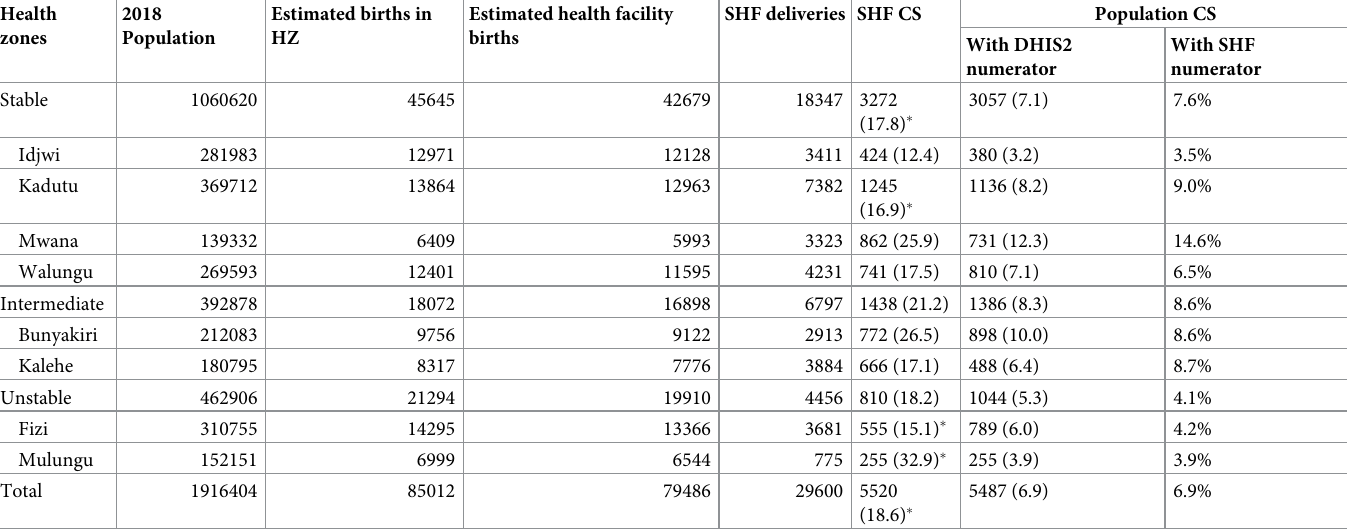
Table 3. Estimated health facility delivery and population CS rate estimates by conflict